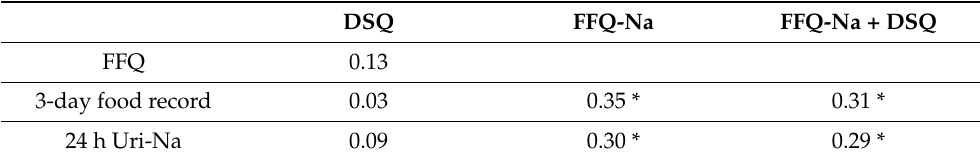
Table 4. Spearman correlation coefficients between the DSQ and the FFQ-Na, as well as the cor- relations of the DSQ, the FFQ-Na and the FFQ-Na + DSQ, with the 3-day food record and 24 h Uri-Na. DSQ FFQ-Na FFQ-Na + DSQ FFQ